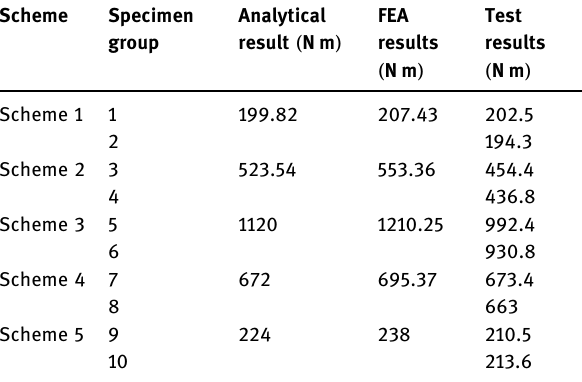
Scheme Specimen